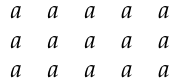
Figure 6. A picture array in L (cid:48)